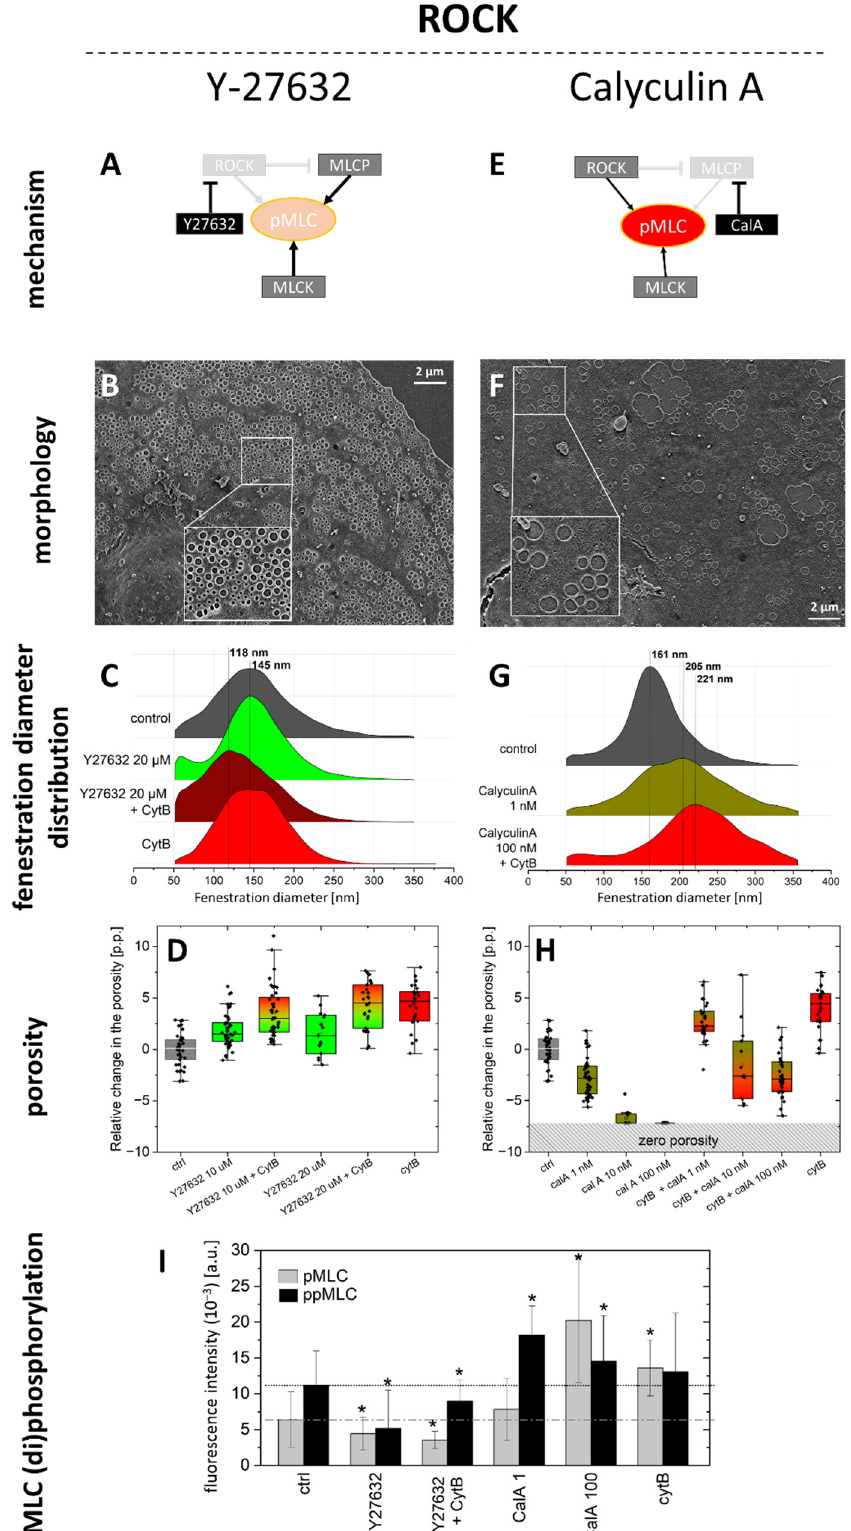
Figure 2. The effect of ROCK and MLCP inhibition on fenestrations in LSEC. ( A ) Schematic presentation of the mechanism of ROCK inhibition by Y27632. MLC is partially dephosphorylated (faded-red colour) by direct ROCK inhibition by Y27632. Phosphorylation by MLCK is still possible, but MLCP cannot be phosphorylated (deactivated) by ROCK, causing additional dephosphorylation. ( B ) Representative SEM image of LSEC treated with 10 µM Y27632+CytB. The inset highlights two